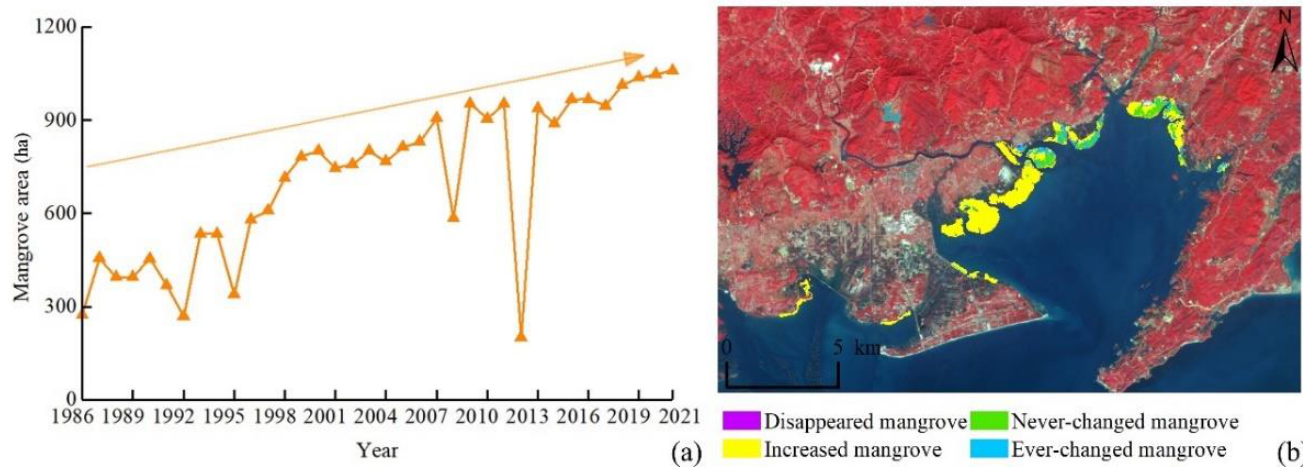
Figure 12. ( a ) Mangrove area and ( b ) changes to mangroves in BNNR during 1986 – 2021.